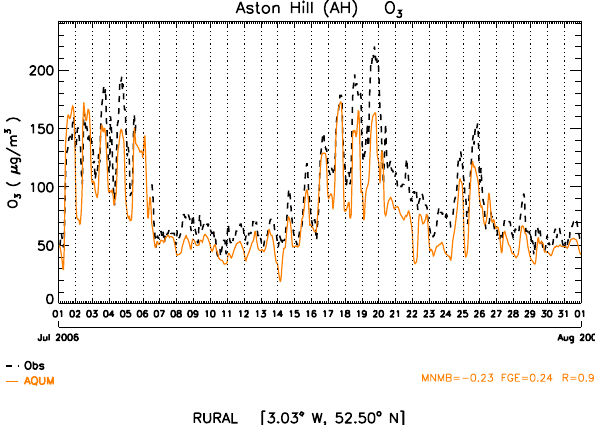
Fig. 6. Time series of hourly ozone concentrations (µgm − 3 ) for the rural site at Aston Hill, for July 2006. Observed concentrations are shown as the black dashed line and the model output as the solid orange